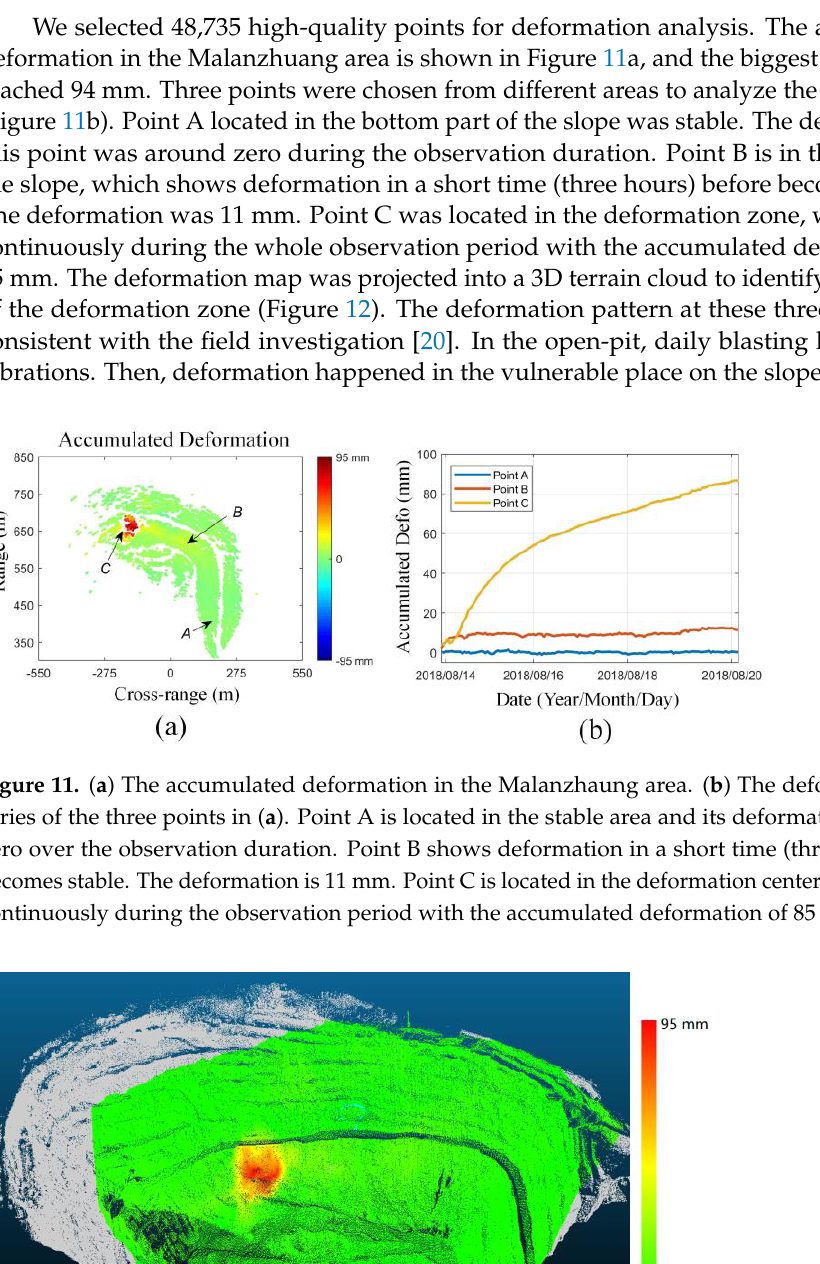
Table 4. The standard deviations of the residual phase for the four points in time series obtained by the range-related model and the 3D model (mm). Figure 10. ( a ) The observed deformation in the interferograms for the four points of the Malan- zhuang area in Figure 9c. ( b ) the deformation compensated by the height-related model. ( c ) the deformation compensated by 3D model.